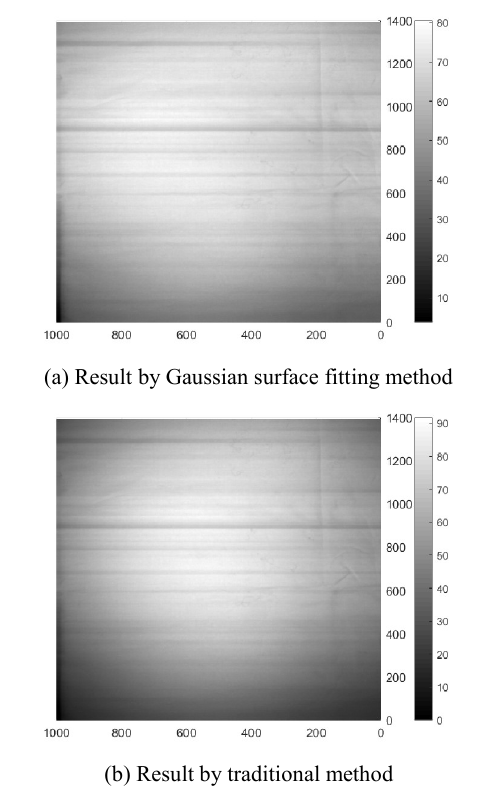
Figure 4. The results of two methods of 440 th band (644 nm) In order to evaluate the reconstruction accuracy quantitatively, the mean, standard deviation and the coefficient of variation of the whole bands are calculated and plotted in Figure